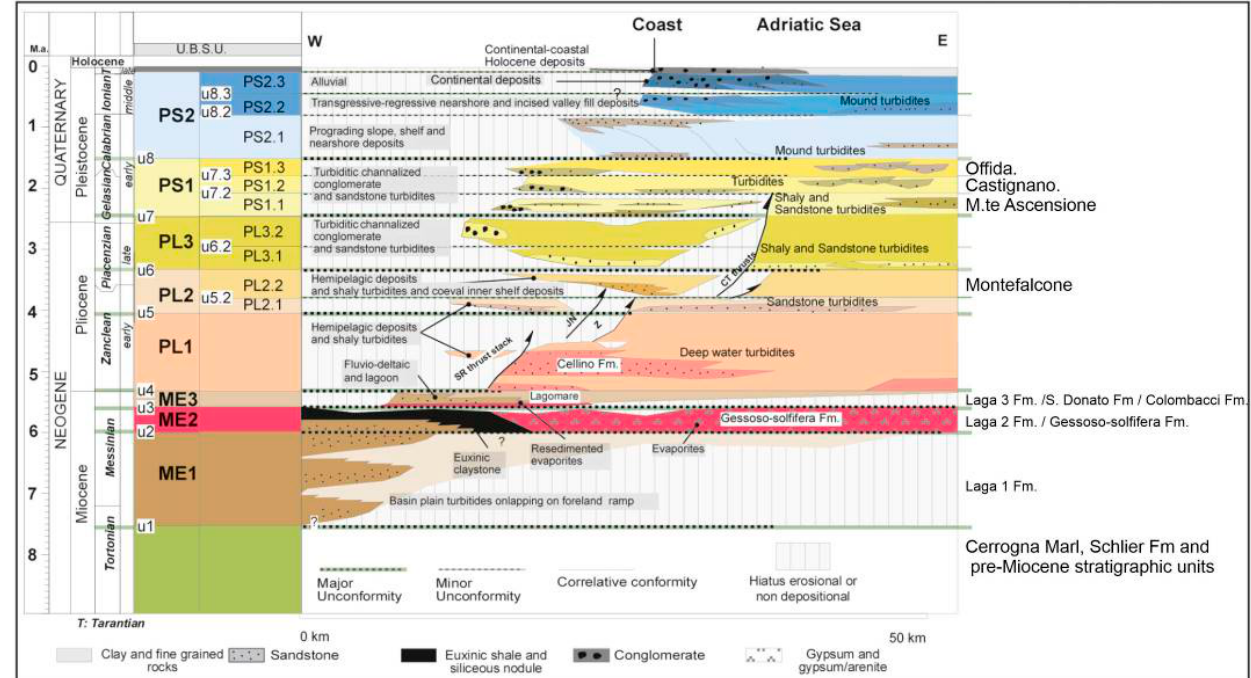
Figure 2. Synthetic stratigraphic scheme of the Messinian–Pleistocene of the Central Periadriatic Basin (CPB; slightly modified from [32]). This scheme includes the stratigraphic schemes of previous studies [11,13,27,50,59], but in the right column we list only the units and members of our study area.